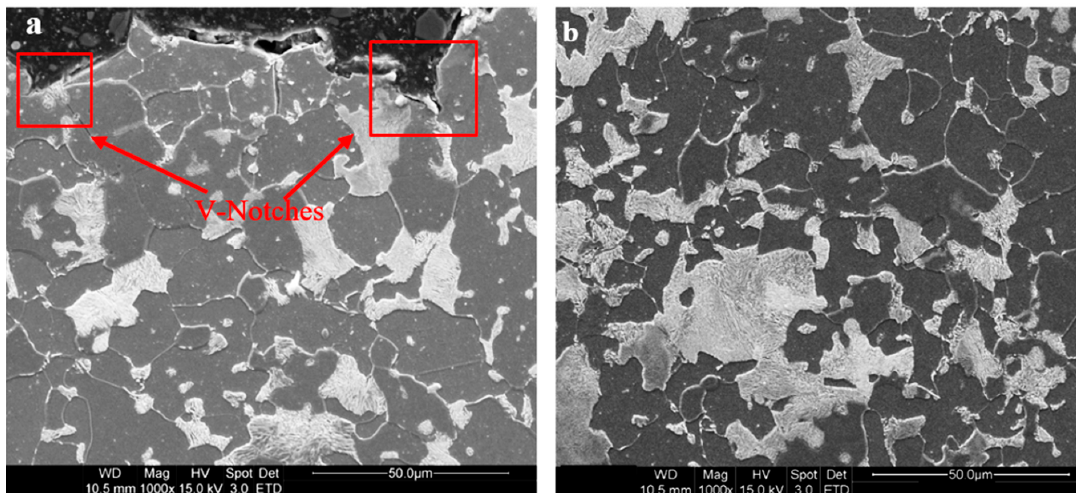
Figure 3. Typical ferritic–pearlitic microstructure from ( a ) the surface and ( b ) the bulk of slabs.